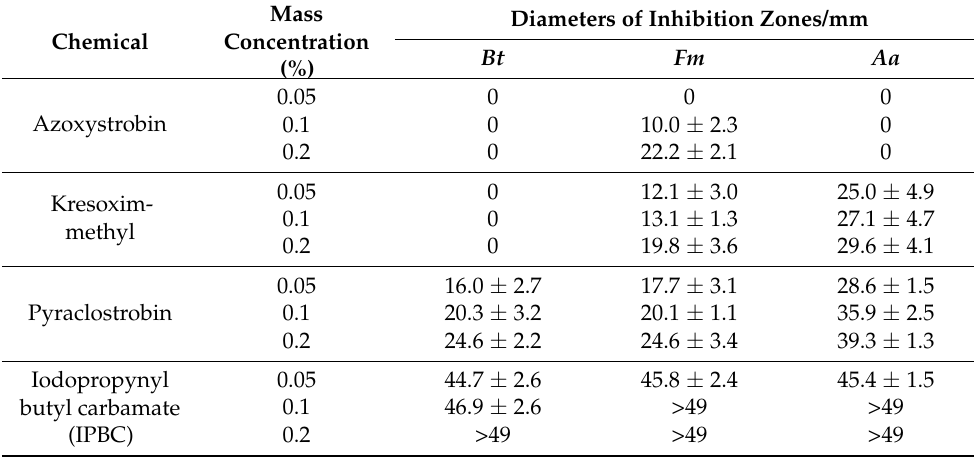
Table 2. The result of the inhibition zone tests for stain fungi.